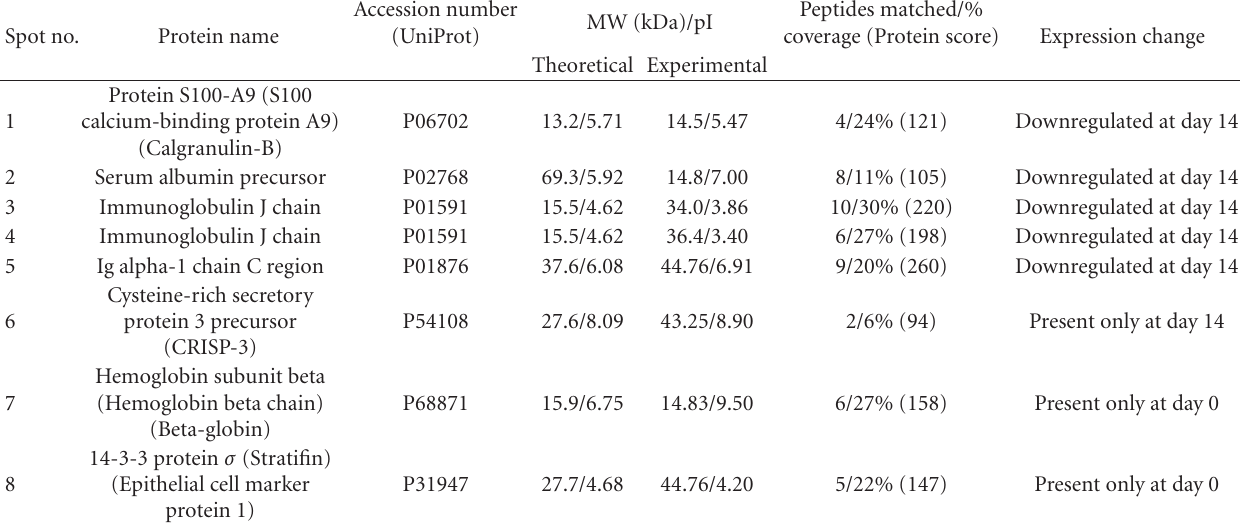
Table 1: Summary of saliva proteins with expression change during orthodontic treatment.